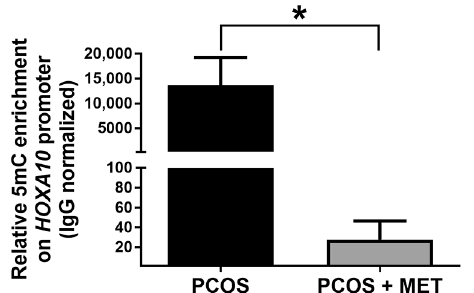
Figure 4. Effect of intervention with metformin and a carbohydrate-controlled diet on the content of DNA methylation at the promoter of HOXA10 gene in PCOS patients. The relative level of 5- methylcytosine (5mC) enrichment on the promoter of HOXA10 is shown for PCOS patients without treatment (PCOS) and after intervention (PCOS + MET). Data were obtained using MeDIP-qPCR and analyzed with the ΔΔ Ct method, normalizing with IgG enrichment. Results are expressed as mean ± SE. * p ≤ 0.05 vs. PCOS.